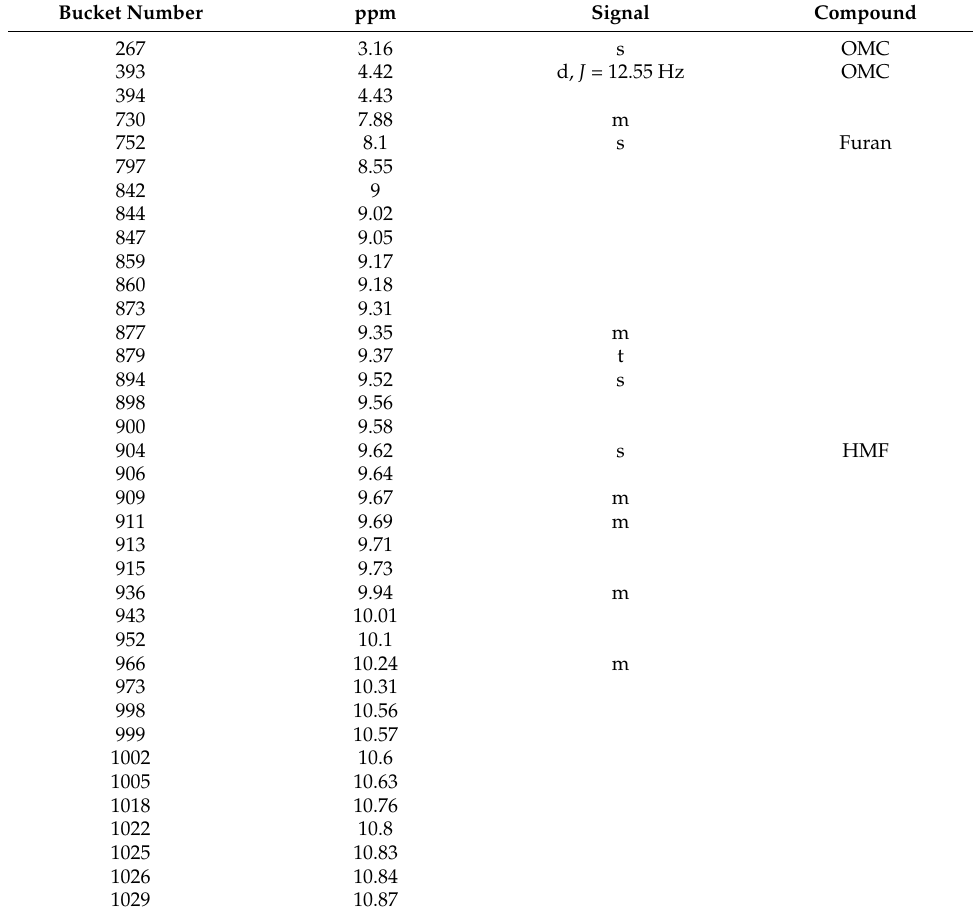
Table A1. Selected variables using rPLS with some assignments (m = multiplet, s = singlet, d = duplet, t = triplet, and J =